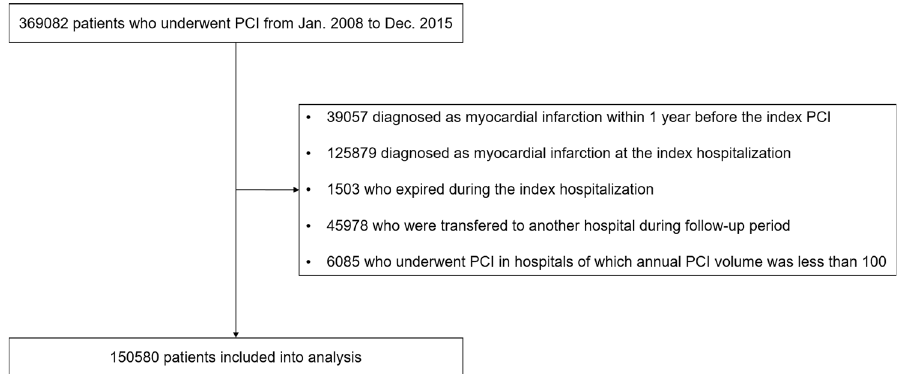
Figure 1. Overview of the study population. PCI percutaneous coronary intervention.